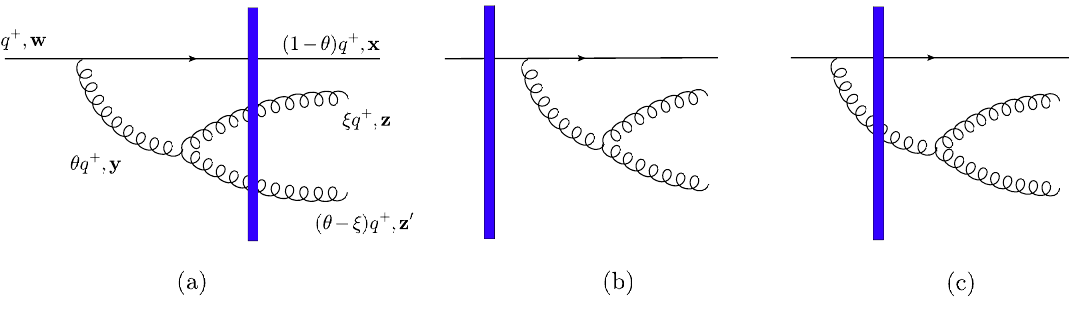
Figure 7 . The three possible shockwave insertions for a final partonic state built with one quark and two gluons: (a) final-state scattering, (b) initial-state scattering, and (c) intermediate-state